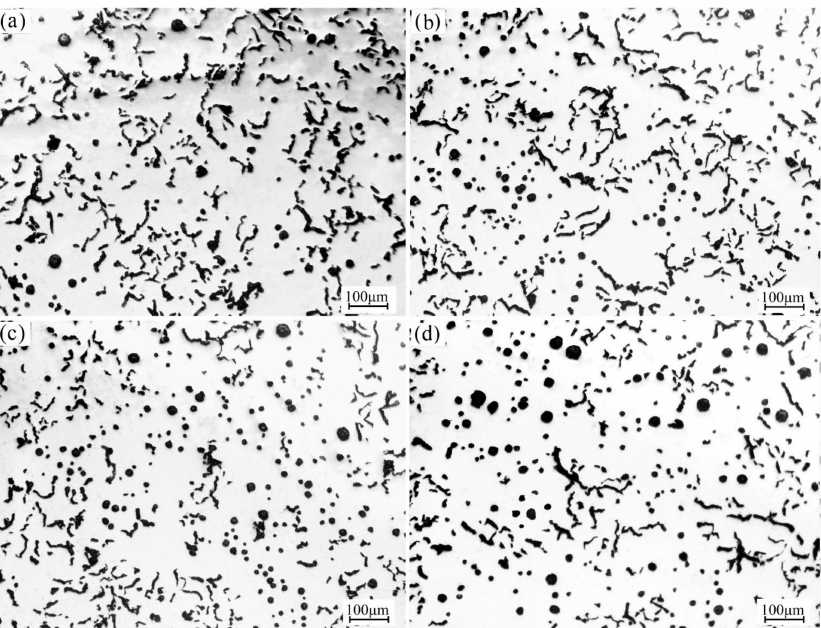
Figure 8. Graphite morphology at the central area of thermal analysis samples with different amounts of FeSi75: ( a ) 0% FeSi75, vermicularity 89%, area fraction of graphite 0.115, ( b ) 0.15% FeSi75, ver- micularity 78%, area fraction of graphite 0.113, ( c ) 0.30% FeSi75, vermicularity 58%, area fraction of graphite 0.102, ( d ) 0.45% FeSi75, vermicularity 46%, area fraction of graphite